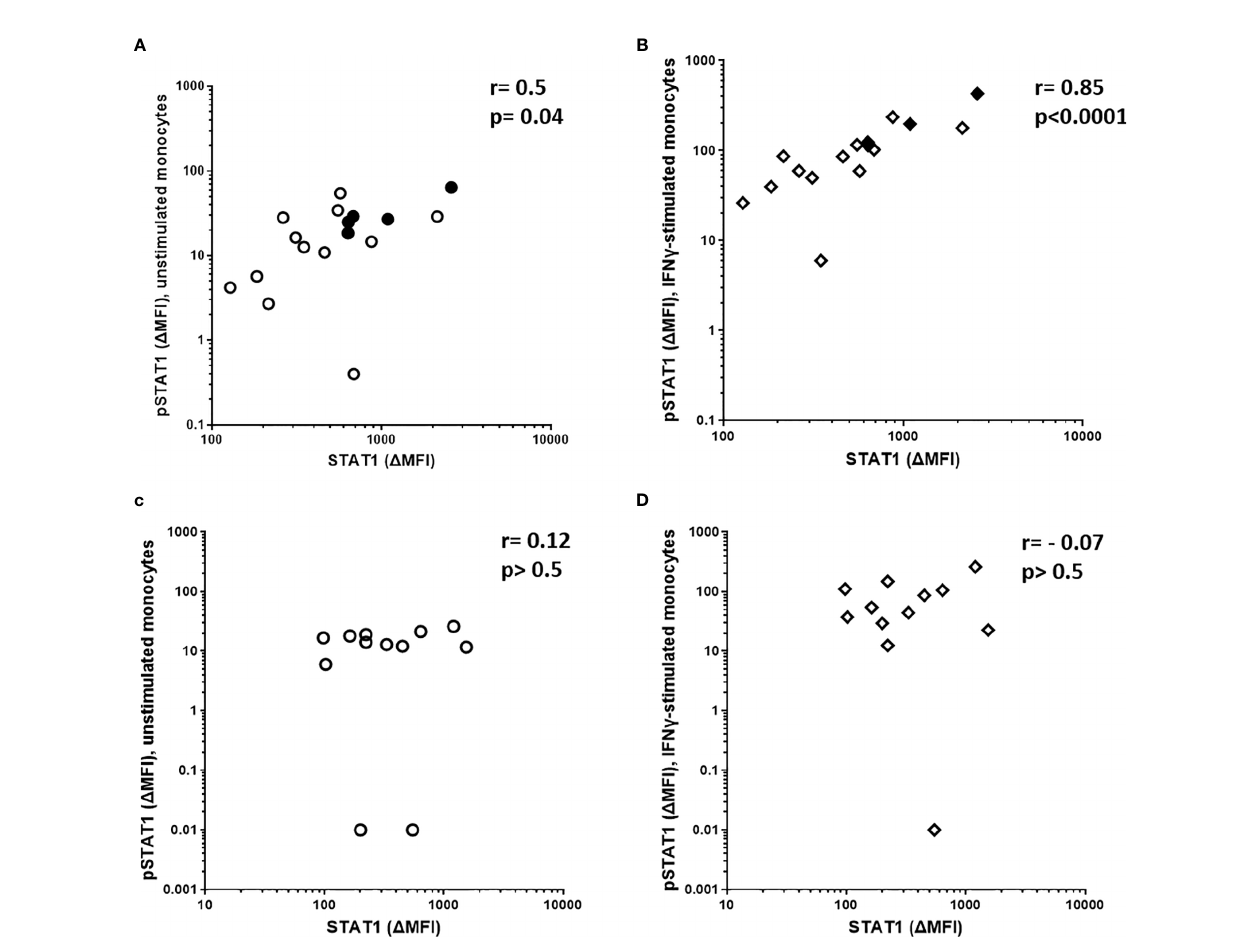
FIGURE 3 | Total STAT1 levels are signi fi cantly correlated with pSTAT1 levels in monocytes of sHLH/MAS patients, but not in those of active sJIA patients. (A, B) Total STAT1 levels were correlated with pSTAT1 levels in monocytes unstimulated (n=17) or stimulated (n=16) with IFN g (10 ng/Mml) from sHLH/MAS patients. Full diamonds and circles indicate samples from untreated sHLH/MAS patients. (C, D) Total STAT1 levels were correlated with pSTAT1 levels in monocytes unstimulated (n=12) or stimulated (n=12) with IFN g (10ng/ml) from active sJIA patients. Correlations were tested using Spearman ’ s rank order test. A base-10 log scale is used for the y and x axes of graphs (A – D)